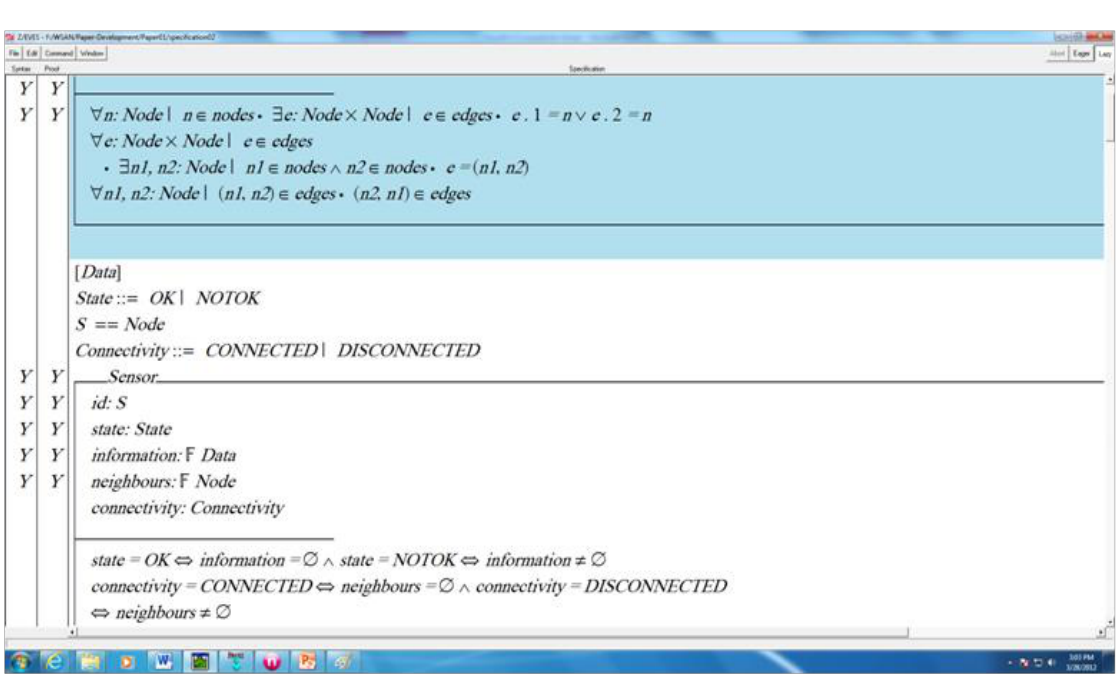
Figure 7. Snapshot of the model